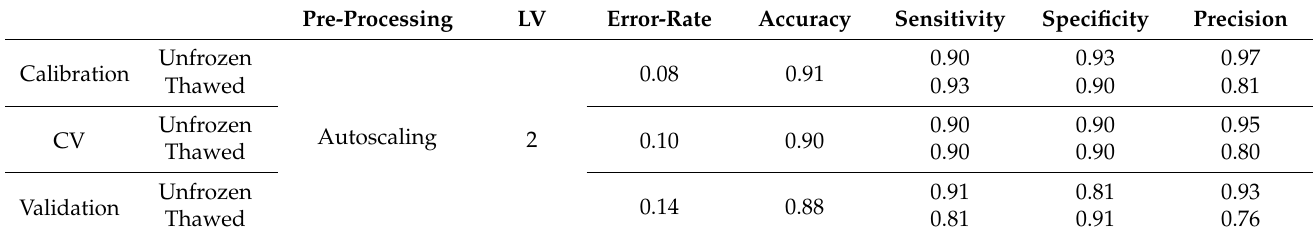
Table 2. BIA results.